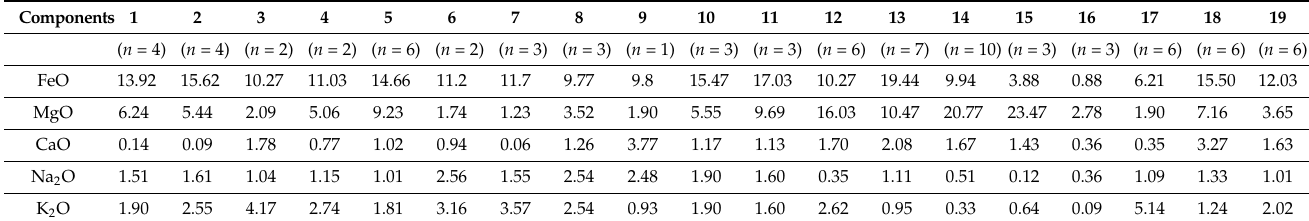
Table 1. The average chemical composition of mixed-layer chlorite–smectite minerals and corrensites of different genetic groups (fractions less than 1 µ m).